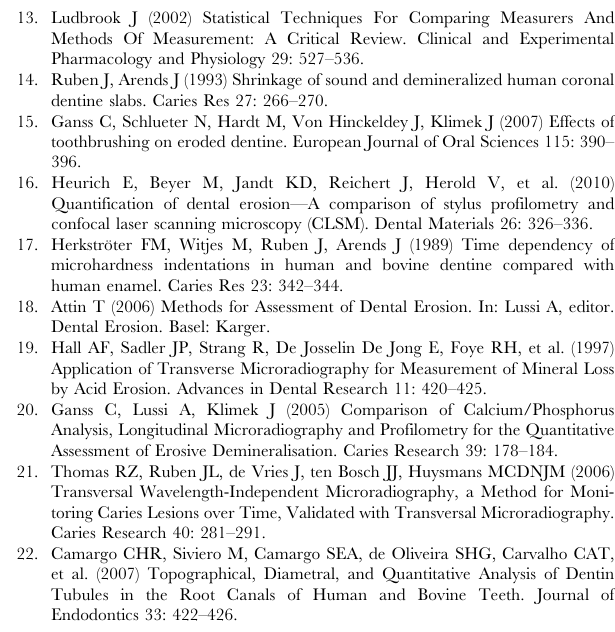
Table S1 Erosive substance loss in each group as measured using the four different methods by examiner